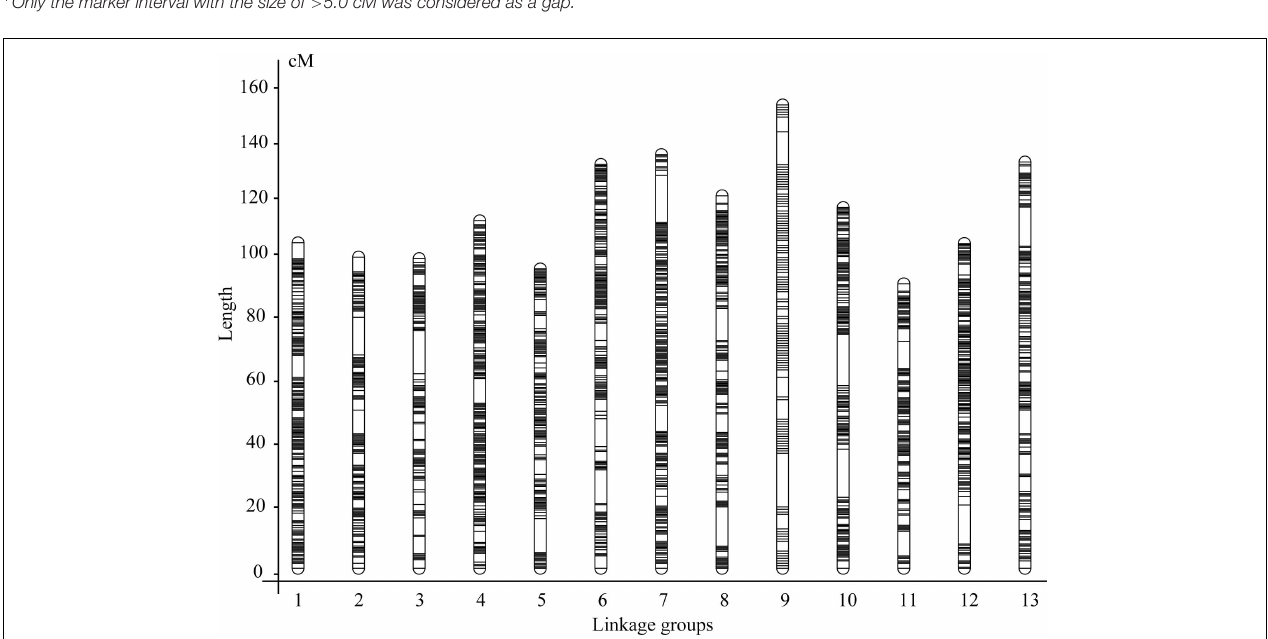
FIGURE 2 | The superdense genetic map constructed using an improved pipeline and the F 2 population derived from a cross between Yuzhi DS899 and JS012.